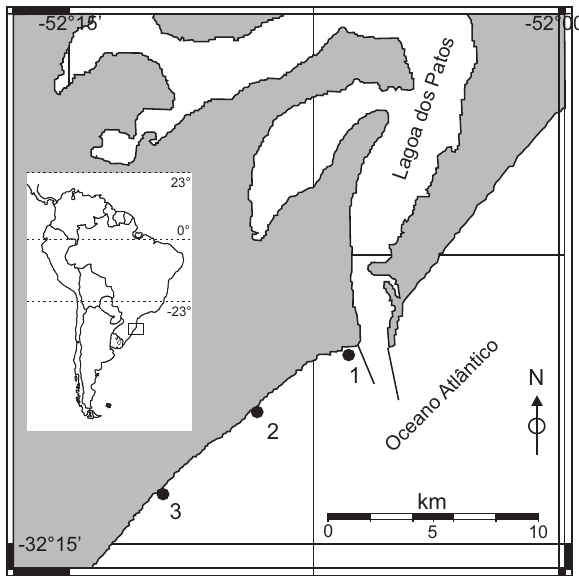
Figura 1. Mapa da área de estudo com detalhe da Praia do Cassino e dos locais de